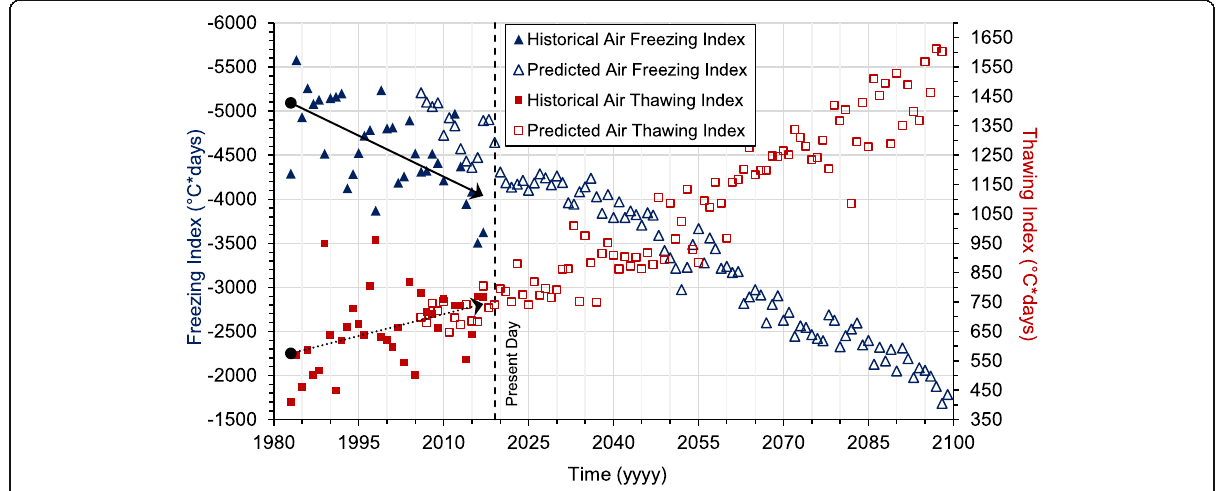
Fig. 5 Historical and predicted air freezing and thawing